Question: Judging by this figure, is the value going up or going down?
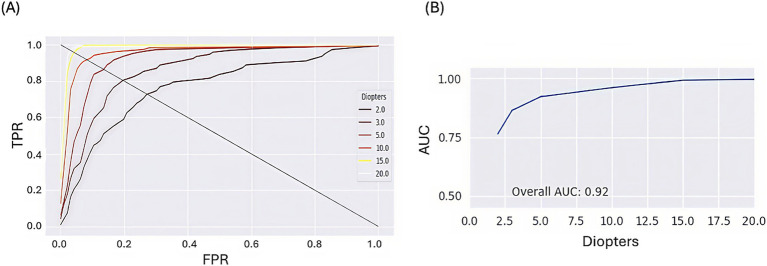
Answer: increasing